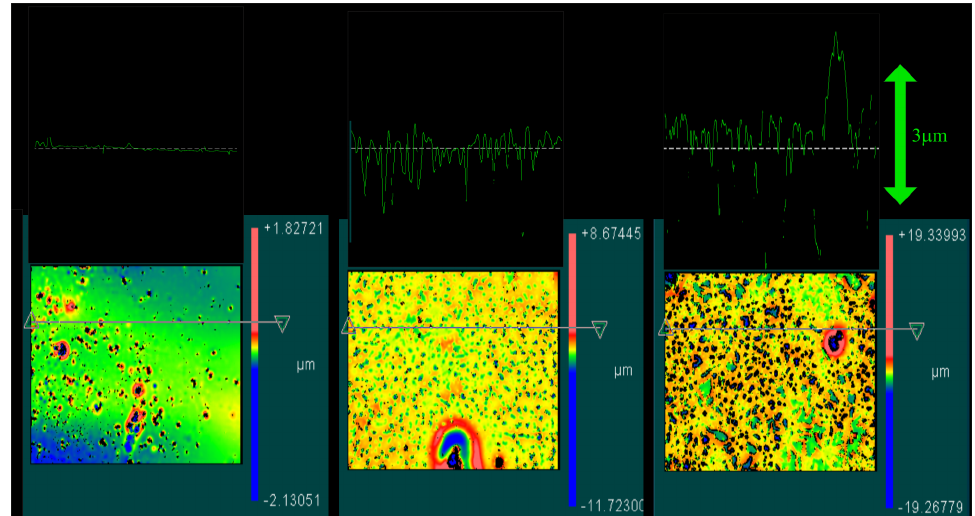
Figure 4. Three artificially weathered specimens of glass covered with protective layer: 0 weeks (non-weathered), 3 weeks, and 5 weeks old. Above: horizontal profiles, below: false color height maps. Field of view 3.53 × 2.56 mm.